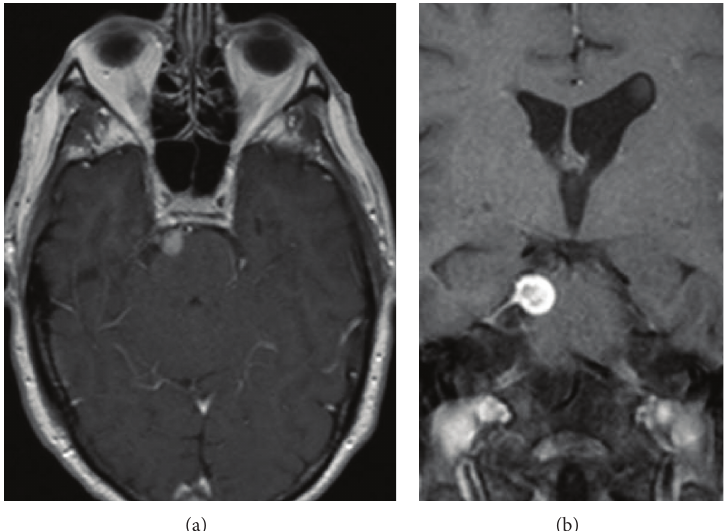
Figure 1: Preoperative MRI brain with contrast axial (a) and coronal T1-weighted (b) images reveals a well-circumscribed, heterogeneously enhancing lesion adjacent to the right side of the upper pons.